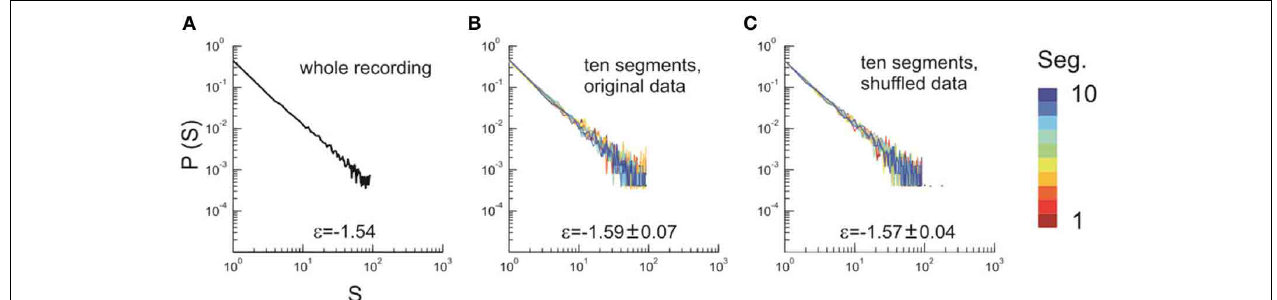
Avalanche pattern size distributions were calculated for individual segments and plotted (color coded). (C) The original dataset as analyzed in (A) was shuffled in time (i.e., the sequence of activities was randomized) to eliminate temporal dependencies and split into ten consecutive, equal-sized segments. Avalanche pattern size distributions were calculated for individual segments and plotted (color coded). In (B) and (C) , ε is represented as mean ± s.d. (across all segments).